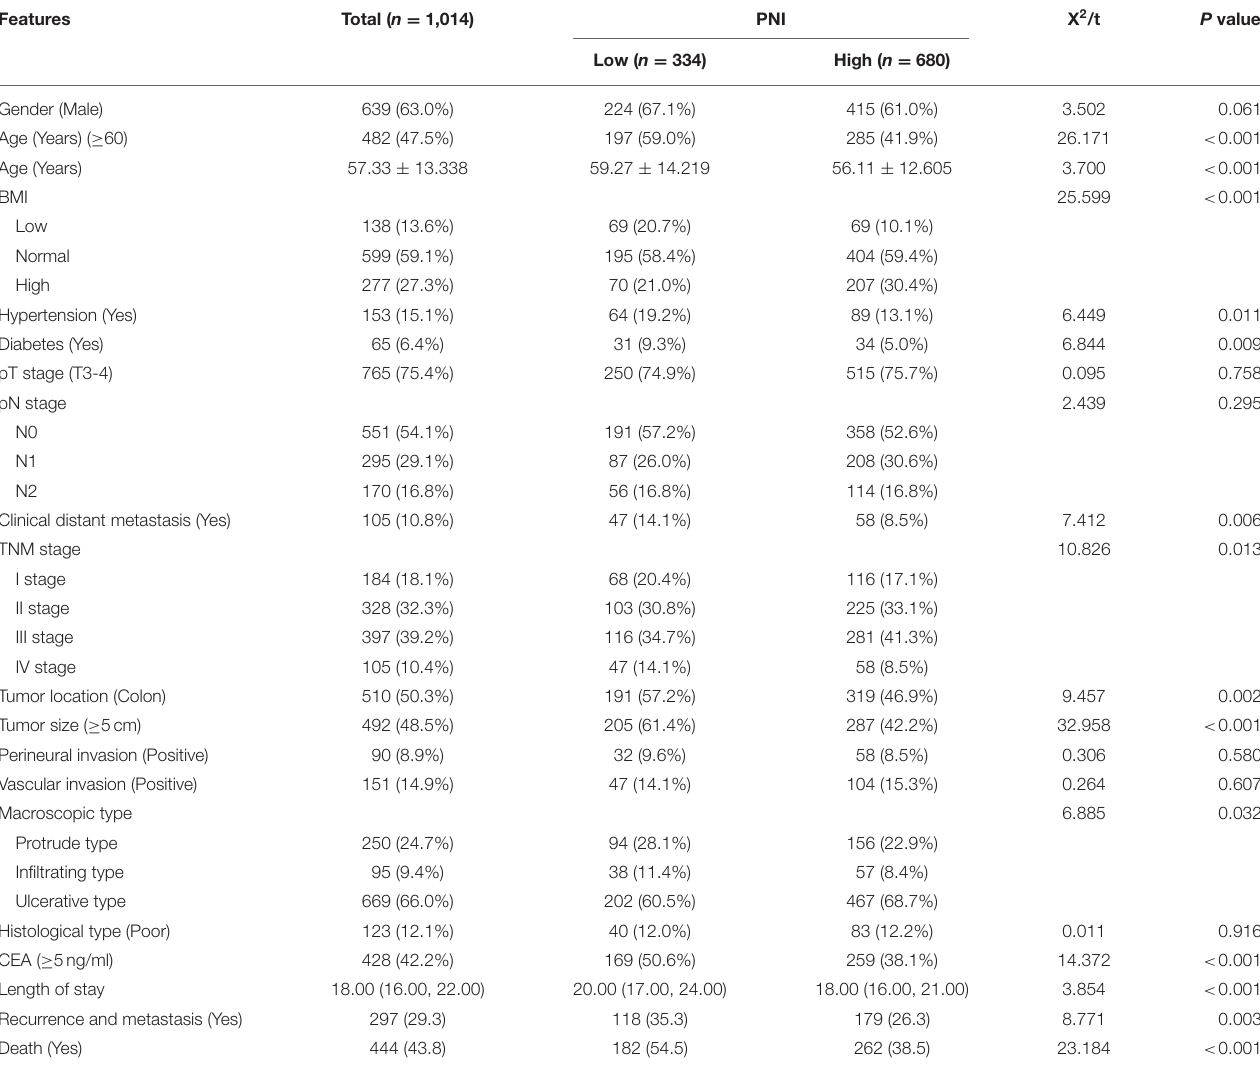
TABLE 1 | The relationships between the PNI and clinicopathological factors of CRC patients.